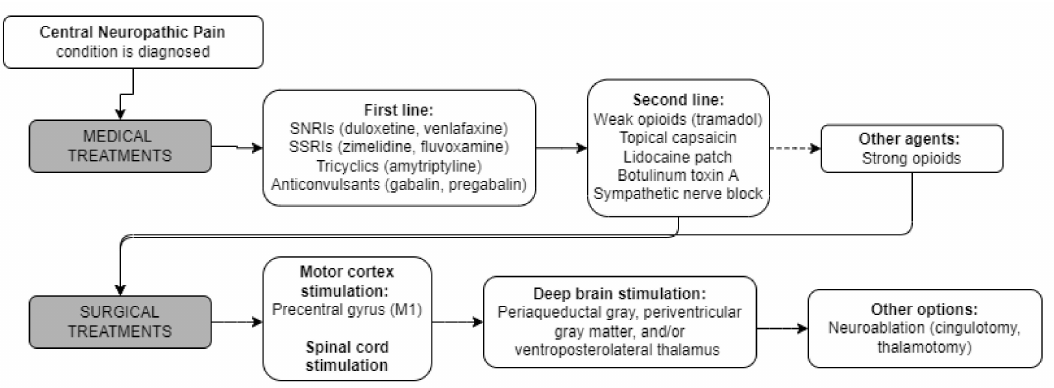
Figure 1. Flowchart of potential treatments for central neuropathic pain